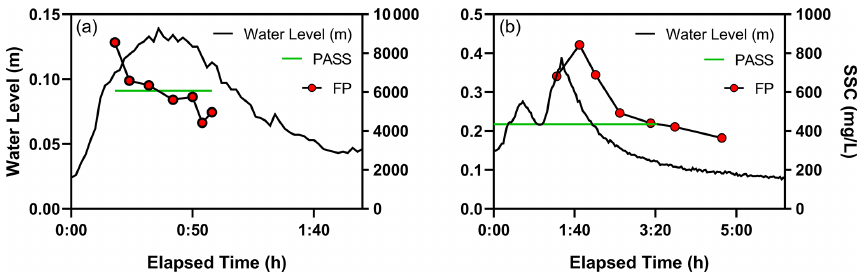
Figure 4. Relationship between SSC and stream height for single flow events in the control ( a – flow event B) and remediated ( b – flow event F) gullies that occurred during the 2018–2019 wet season (Sect. S3). Water level (black line), PASS TWA SSC (green line), and flow proportional (FP) sampling (red circles with black line) are shown.